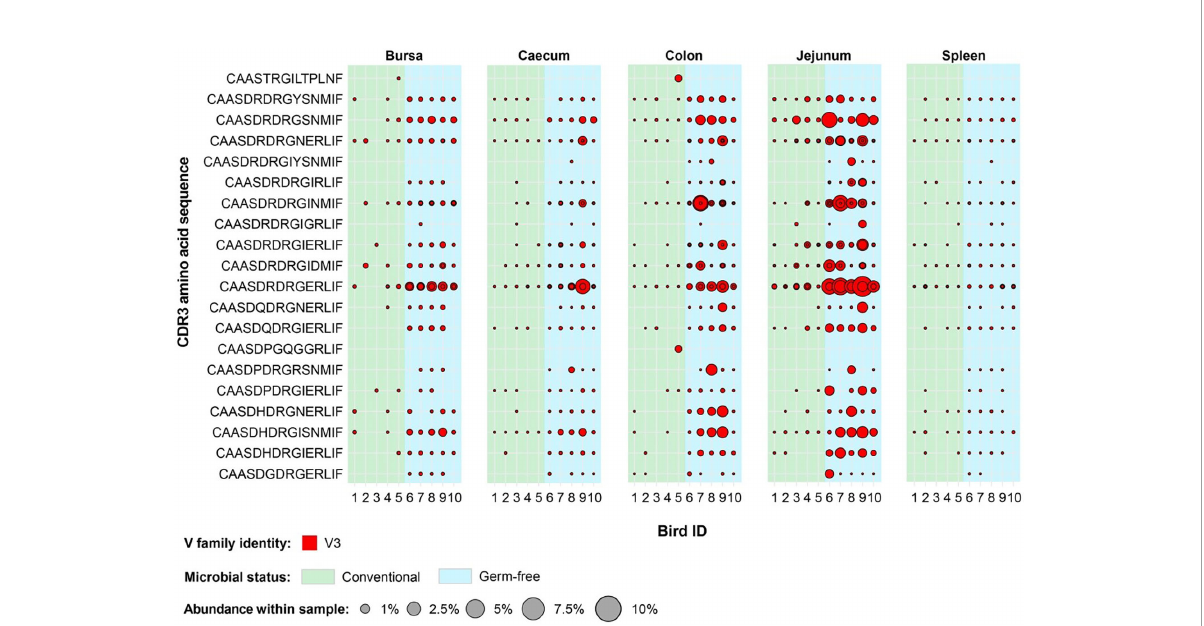
FIGURE 13 Clonally expanded V b 3 CDR3 in tissues of germ-free and conventional birds. Red circles indicate the presence of clones with a speci fi c CDR3 amino acid sequence and are proportional to the abundance within each bird ’ s (total) tissue clonal compartment. Overlapping circles display different clones based on nucleotide sequence which share the same CDR3 amino acid sequence. The plot depicts V b 3 clones which are found at expanded (at or above 0.5%) in any of the birds included in this analysis (both germ-free and conventional). Background colours indicate microbial status group identity: green – conventional, light blue –